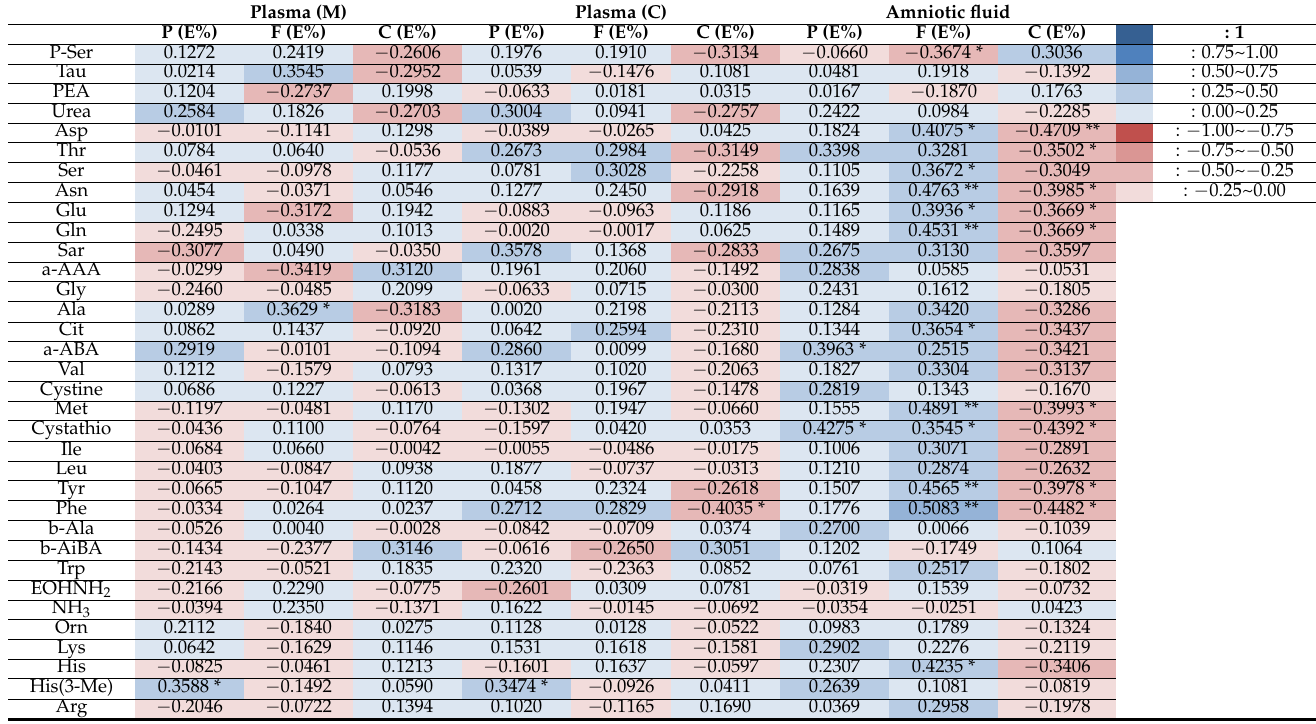
Table 2. Spearman rank correlation coefficients of the amino acid contents of maternal plasma, cord blood plasma, and amniotic fluid samples with the maternal dietary intake of proteins, fats, and carbohydrates.